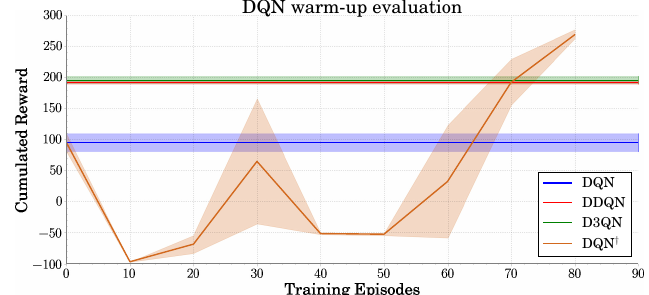
Figure 5. Mean cumulative reward and its deviation for DQN (blue), DDQN (red) and D3QN (green) agents in the second environment. Also, evolution of the cumulative reward for DQN † (orange) over the number of retraining